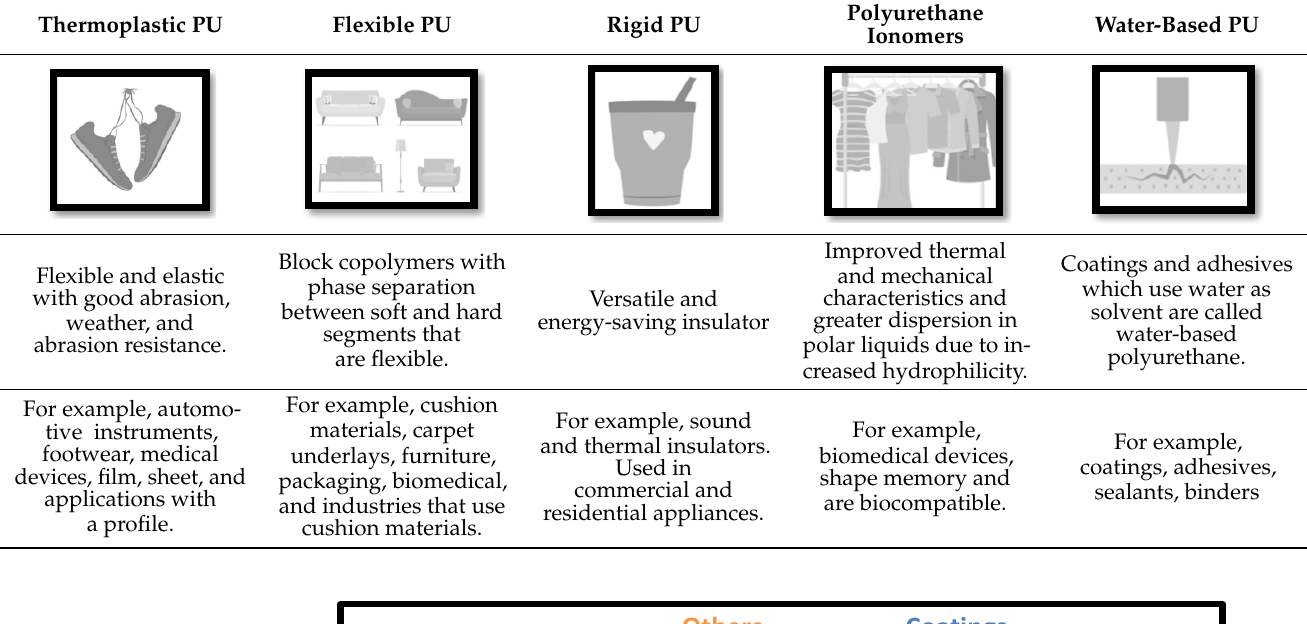
Figure 1. Formation of Urethane Linkage.